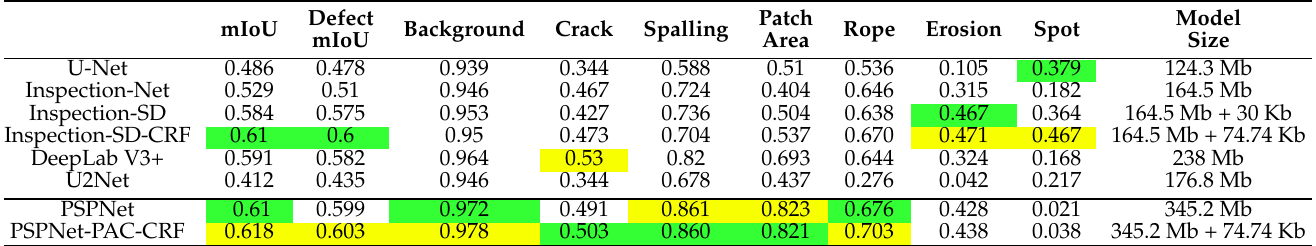
Table 2. Result comparison of different networks on test set best second best.